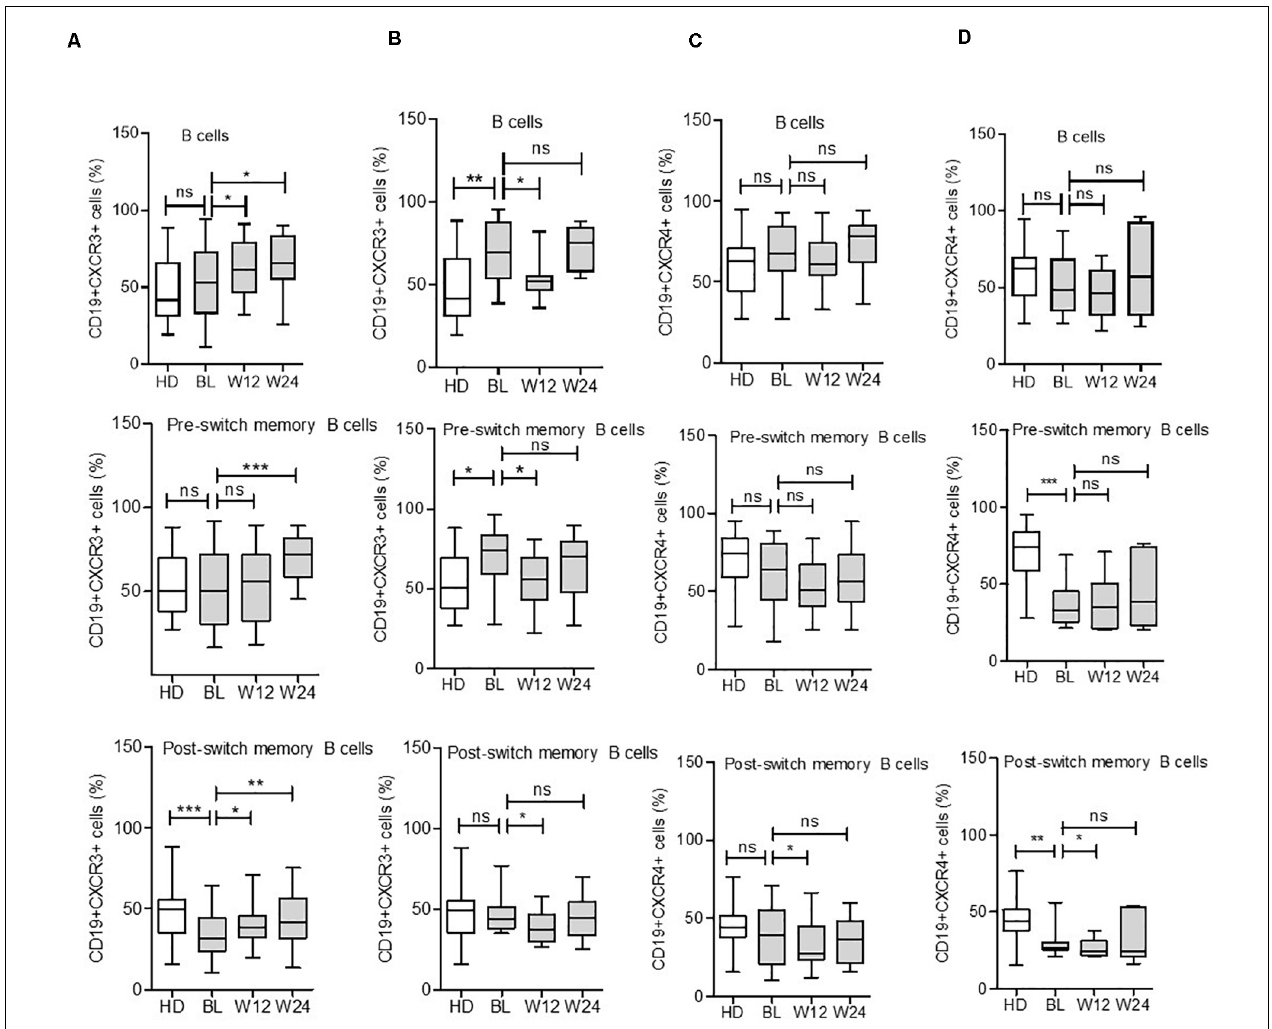
FIGURE 5 | Expression of CXCR3 and CXCR4 in B cell subsets during IL-6R and TNF inhibition therapy. CXCR3 expression on B cell subsets increases in some subsets during IL-6R inhibition (A) and decreases during TNF- α inhibition (B) therapy. CXCR4 expression on B cell subsets reduces in certain subsets during IL-6R inhibition (C) and TNF- α inhibition (D) therapy. Values were consistently compared with baseline levels using the Student unpaired t -test (*** p < 0.0001, ** p < 0.001, and * p < 0.01). BL = baseline, W12 = week 12, and W24 = week